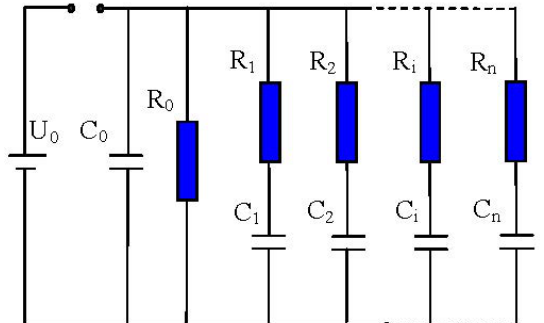
Figure 4. Modelling the dielectric response of a multilayer insulation by means of equivalent